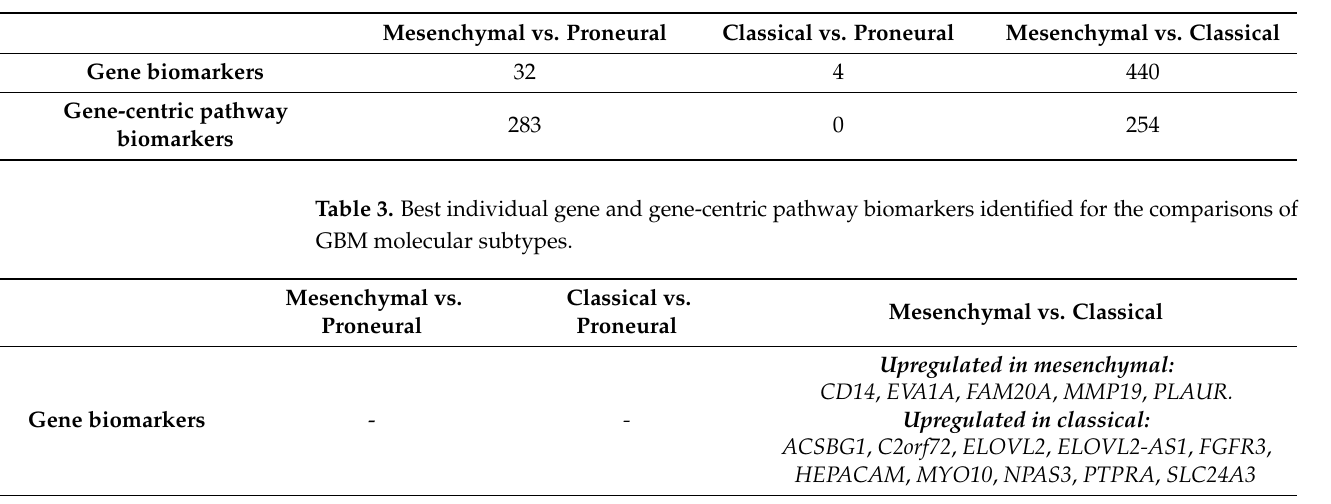
Table 3. Best individual gene and gene-centric pathway biomarkers identified for the comparisons of GBM molecular subtypes.